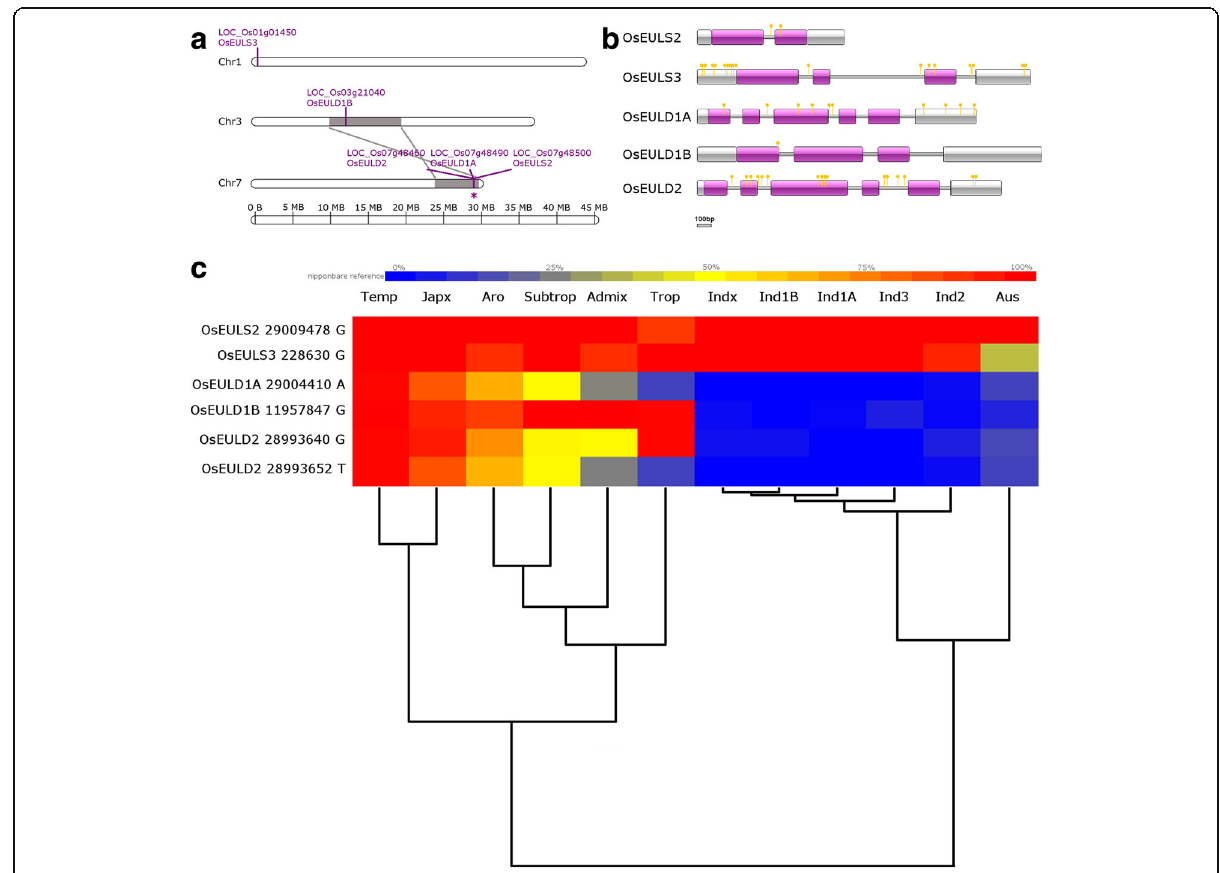
Fig. 1 Comparison of DNA sequences encoding EUL homologs from O. sativa . a . Distribution and duplication of EUL genes in the Oryza sativa subsp. japonica genome. Sequences for the different EULs were mapped on the chromosomes based on their start position and annotated with their locus number. Blocks containing EUL genes resulting from segmental duplication events are indicated in gray and connected by lines. Tandem duplications are indicated by an asterisk. The chromosome map was prepared using MapChart and drawn to scale. b . Intron-exon structure of the EUL genes. Shown in white are the 5 ′ and 3 ′ UTRs, exons are shown in purple. Introns are represented by grey bars between the exons. SNPs identified by SNP-seek are indicated in yellow. c . Distribution of SNP alleles in different rice varieties. The percentage of the Nipponbare reference allele in the different subvarieties is indicated by the heat map. The dendrogram is generated by DendroUPGMA (http://genomes.urv.cat/ UPGMA/) (Garcia-Vallve et al.